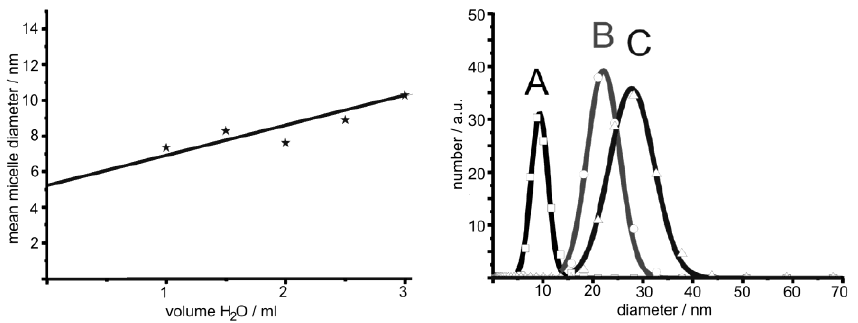
Figure 6. Mean diameter of micelles containing 0.1 M KF-solution in w/o -microemulsions consisting of CTAB, 1 -hexanol and n -dodecane (left) and size distribution of La(OH) hollow spheres prepared via microemulsion-based synthesis with different volumes and concentration of aqueous KF solution as the polar phase: A) 1 ml of 0.2 M KF; B) 1 ml